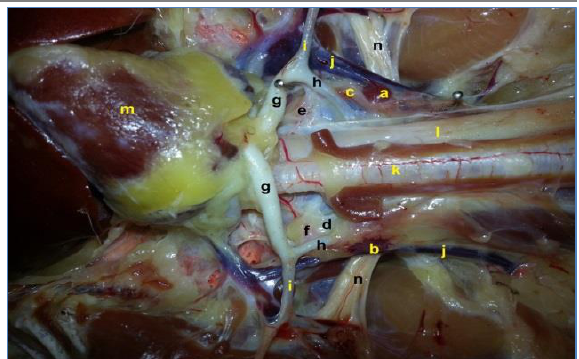
Figure, 2: Photograph showed: a- Right thyroid gland b- Left thyroid gland c- Right parathyroid gland d- Left parathyroid gland e- Right ultimobranchial gland f- Left ultimobranchial g. g- Brachiocephalic artery h- Common carotid artery i- Subclavian artery j- Jugular vein k-Trachea l- Esophagus m- Heart.